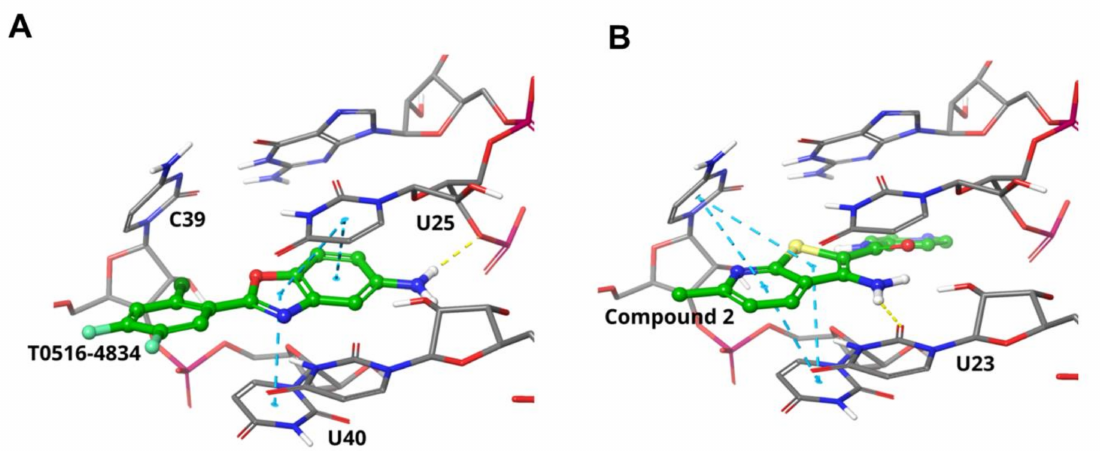
Figure 6. Binding models of HIV-1 TAR RNA complexed with T0516-4834 ( A ) and previously reported thienopyridine compound 2 [16] ( B ). Nucleotides that form the binding cavity are shown in sticks. Pi–pi stacking is shown as light blue dashed